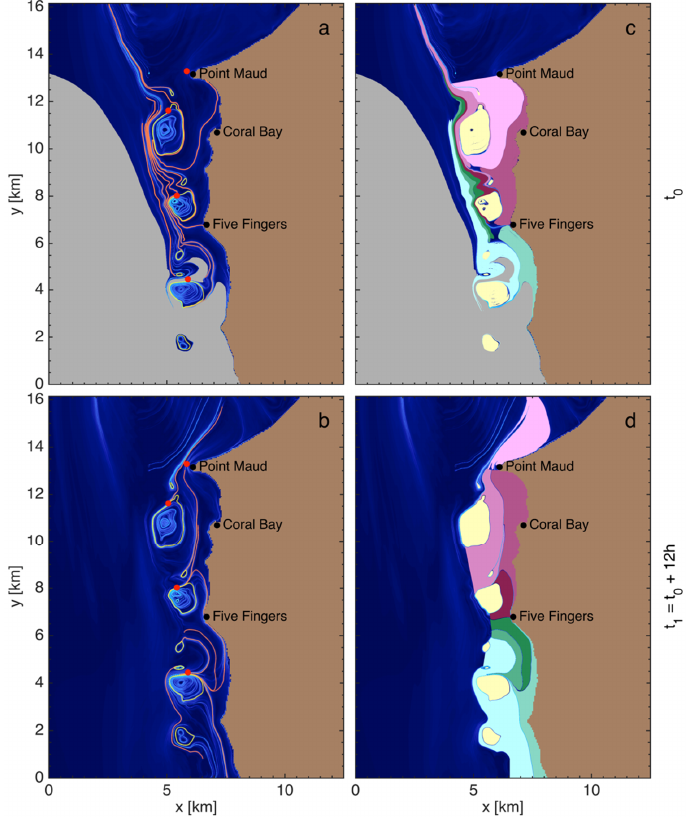
Figure 3. ( a ) The forward (repelling; at time t 0 ) and ( b ) backward (attracting; at time t 1 ) FTLE fields. Plotted are the hyperbolic (orange) and elliptic (yellow) LCS; the hyperbolic are either ( a ) repelling LCS at the initial time t 0 or ( b ) the attracting LCS at the final time t 1 , while the elliptic LCS mark the boundaries of the Lagrangian eddies at both the initial and final times. ( c , d ) Color-coded particle patches initially distributed in the regions defined by repelling LCS are presented in ( c ), and their final distribution is presented in ( d ). The key division of material transport is: (i) relatively stationary material in eddies near the reef channels (yellow), (ii) material that is transported north (purple shades), and (iii) material that is transported south (green shades). The grey regions in ( a ) and ( c ) indicate that the material originating from this location was transported out of the overall numerical flow domain, thus preventing LCS computations. Using the domain partitioning revealed by the LCS in Figure 3a,b, the initial (Figure 3c) and final (Figure 3d) locations of distinct coherent patches of particles delineated by the hyperbolic and elliptic LCS are presented (Movie S1, included with this submission, presents an animation of the intermediate states). The color-coding theme was based on the inspection of the qualitative nature of the advection of the different patches, providing a simplified but insightful view of how the Lagrangian transport is organized within the domain. There are three qualitatively different regions